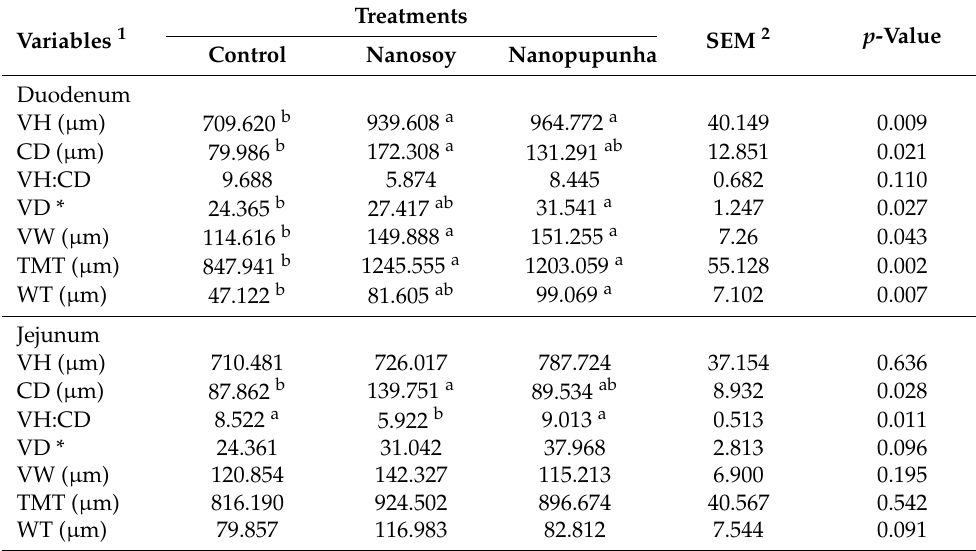
Table 5. Structural analysis and villi density of the intestinal epithelium of growing rabbits fed different sources of nanofibers and those fed a control diet.